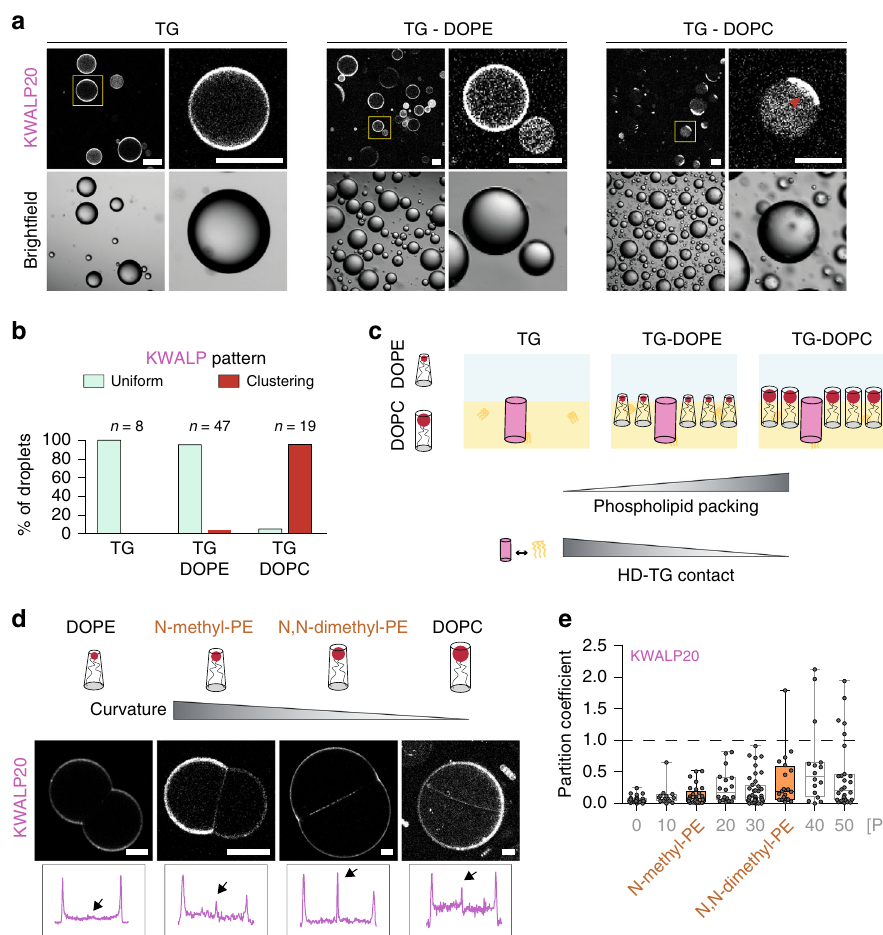
Fig. 4 The partitioning of KWALP is altered by phospholipid shape. a KWALP20 surface distribution in bare TG-buffer droplets or in TG-buffer droplets covered by DOPE or DOPC. Red arrow highlights peptide clustering (in DOPC condition). The yellow square regions are enlarged on the right side of each image. Scale bar: 100 µ m. b Quanti fi cation of KWALP pattern, i.e., uniform (light green) or clustering (red) signal, in TG ( n = 8), TG + DOPE ( n = 47) and TG + DOPC ( n = 19), from n independent measurements. c Schematic representation of the difference in phospholipid packing, and thus in HD-TG contact, when DOPE (cone shape) or DOPC (cylinder shape) are present. Increasing DOPC concentration in a DOPC/DOPE monolayer increases the lipid packing and decreases the contact between HDs and TG. d Distribution of KWALP20 in DOPE, N -methyl-PE, N , N -dimethyl-PE, and DOPC DIBs. These phospholipids have incremental curvature between that of DOPE and DOPC. KWALP20 is labeled with Rh-B. Line pro fi les (not displayed) are drawn perpendicular to the bilayer and monolayers (as described in Fig. 2b); the thickness of the line is 30 – 40% of the bilayer size. Arrows indicate the bilayer signal. Scale bar: 20 µ m. e Partition coef fi cient of KWALP20 in DIBs of different compositions is represented as box-plots (box limits, upper and lower quartiles; middle line, median; whiskers, minimum and maximum value). Sample size is n = 29 and 20 for KWALP20 in N -methyl-PE and N , N -dimethyl-PE respectively. Previous results of varying PC/PE ratios (Fig. 3e) are reported in light gray. Individual data points are indicated. Source data are provided as a Source Data fi